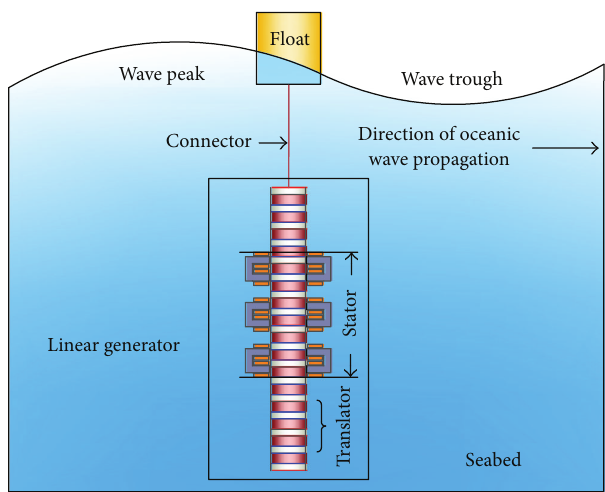
Figure 1: Drawing of the LG connected with a float.